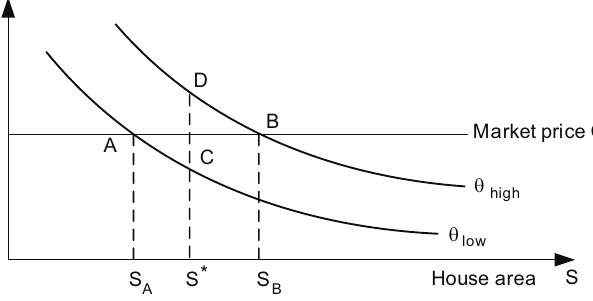
figure 1. Function figure of consumer